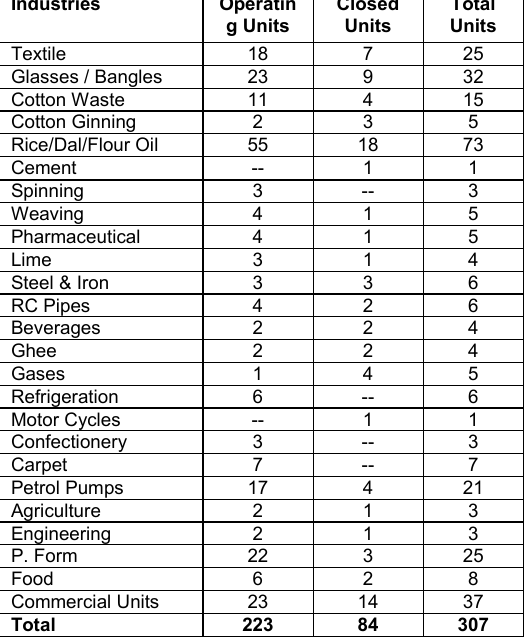
Table 3: Operating and Closed Units at SITE Hyderabad (2004) Industries Operatin Closed g Units